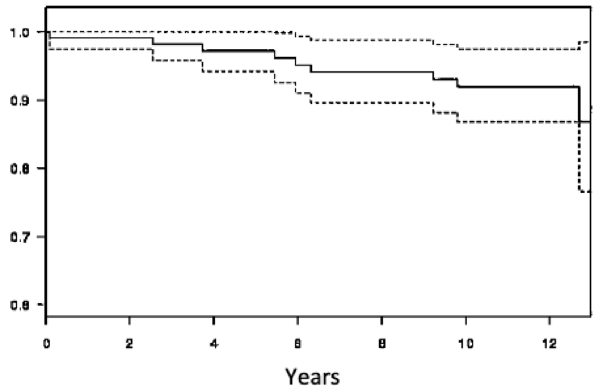
Figure 4. Survivorship of femoral stem aseptic loosening using Kaplan-Meier. Table 2. Complications and adverse